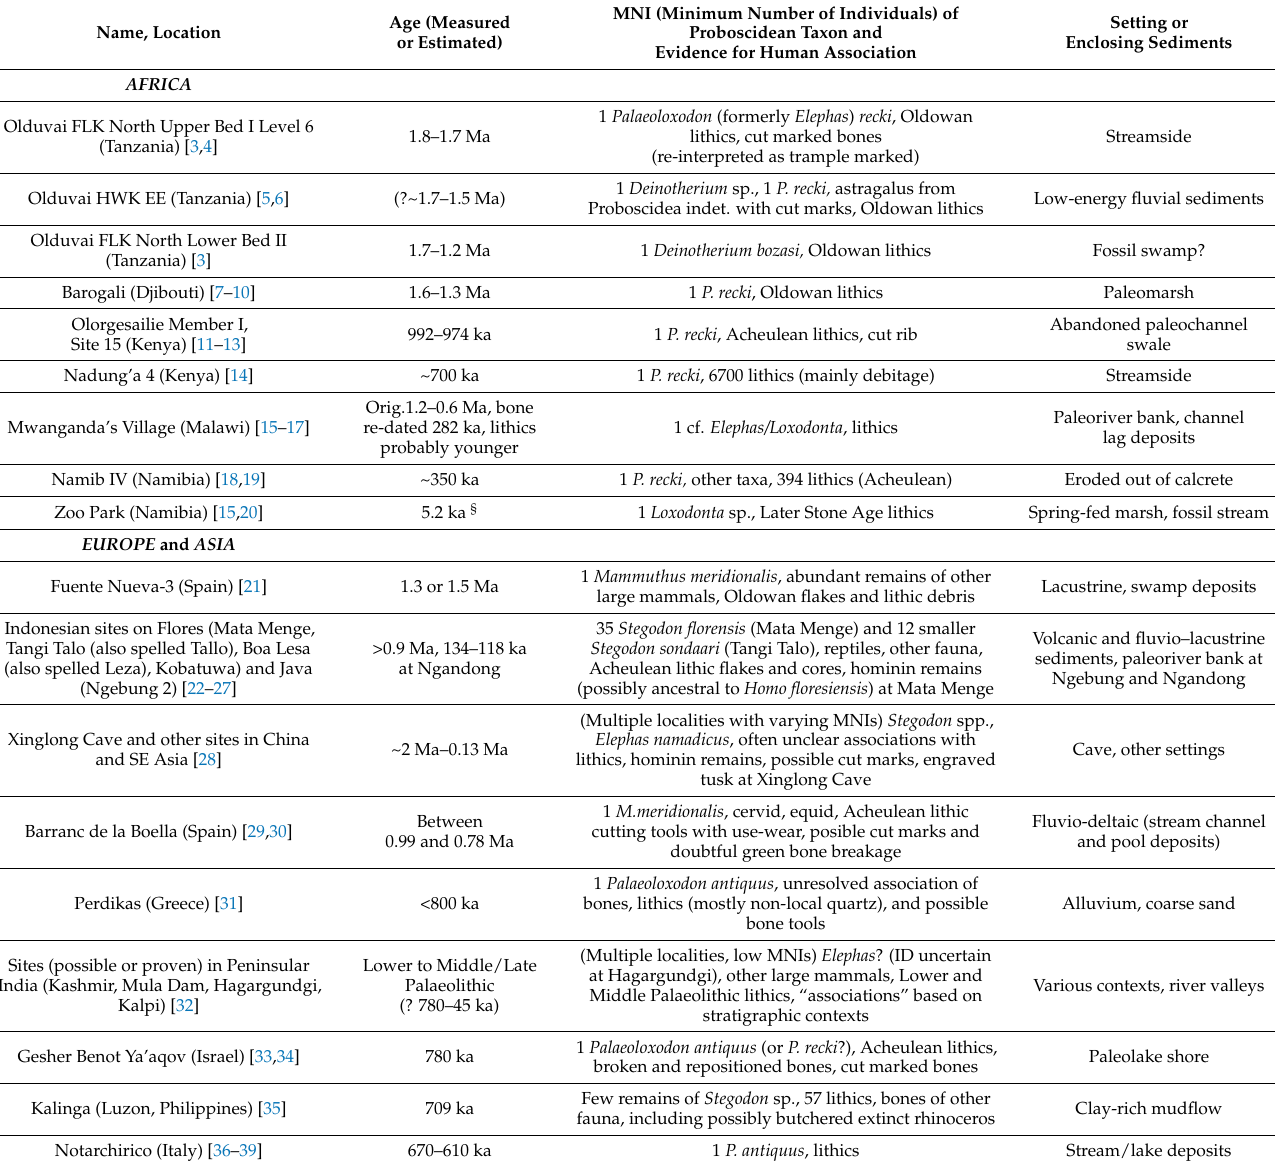
Table 1. Proboscidean sites interpreted as killed/butchered or scavenged by hominins; the references are only samples. The list is arranged by world area, roughly from oldest to youngest in each area. Published citations that refer to Elephas antiquus have been changed to Palaeoloxodon antiquus , following on from [1]. Unless otherwise noted, skeletal elements were often fragmentary, incomplete or collected in multiple localities; MNIs are not always